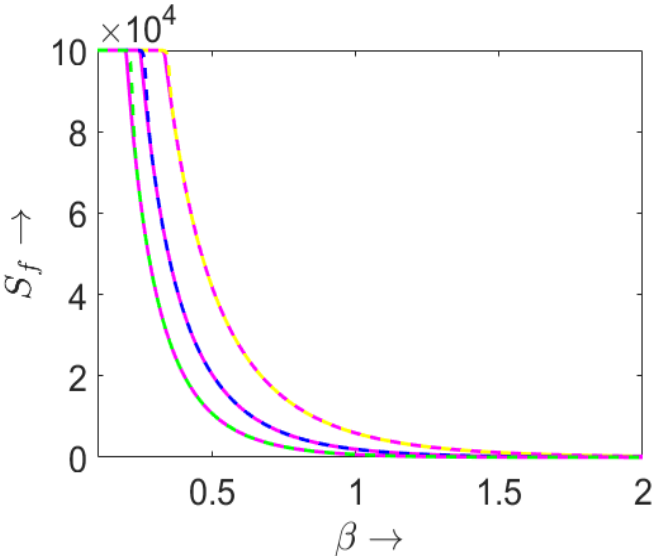
Figure 1. Dependence of S f on β found analytically by Formula (15) and in numerical simulations of (8) for τ = 3 (upper curves), τ = 4 (middle curves), and τ = 5 (lower curves). The analytical and numerical solutions